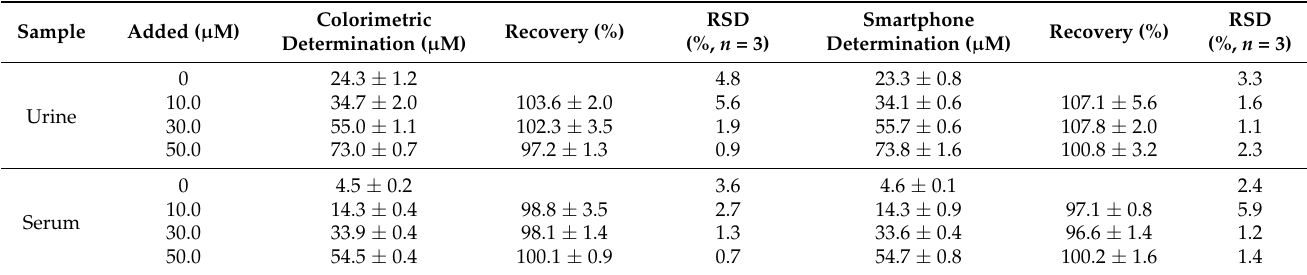
Table 4. Determination of UA content in human urine and serum samples ( n =